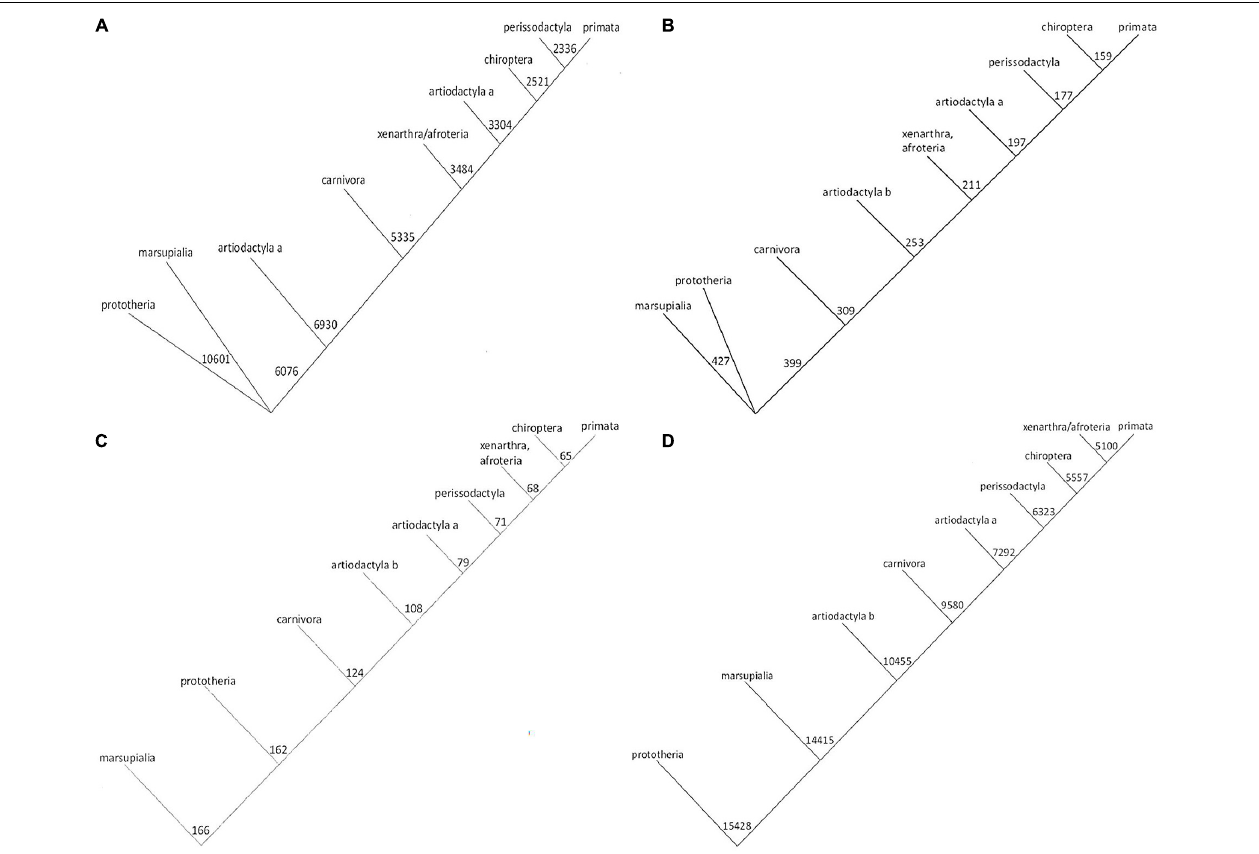
FIGURE 1 | Phylogenetic trees for Osteopontin evolution. The amino acid sequences were converted to strings of numbers. Phylogenetic trees were generated on the basis of calculating the sum differences between all pairs of strings, such that at each step the two strings with the smallest sum-difference between them were averaged before moving to the next step and repeating the process. The numbers express the distances as calculated from the indicated properties, the lengths of the lines are drawn to scale (they are proportional to the numerical differences calculated). The trees in panels (A,B) versus panels (C,D) offer distinct hypotheses for evolutionary relatedness. (A) Tree based on amino acid volume. (B) Tree based on amino acid hydropathy. (C) Tree for octanol interface. (D) Tree for